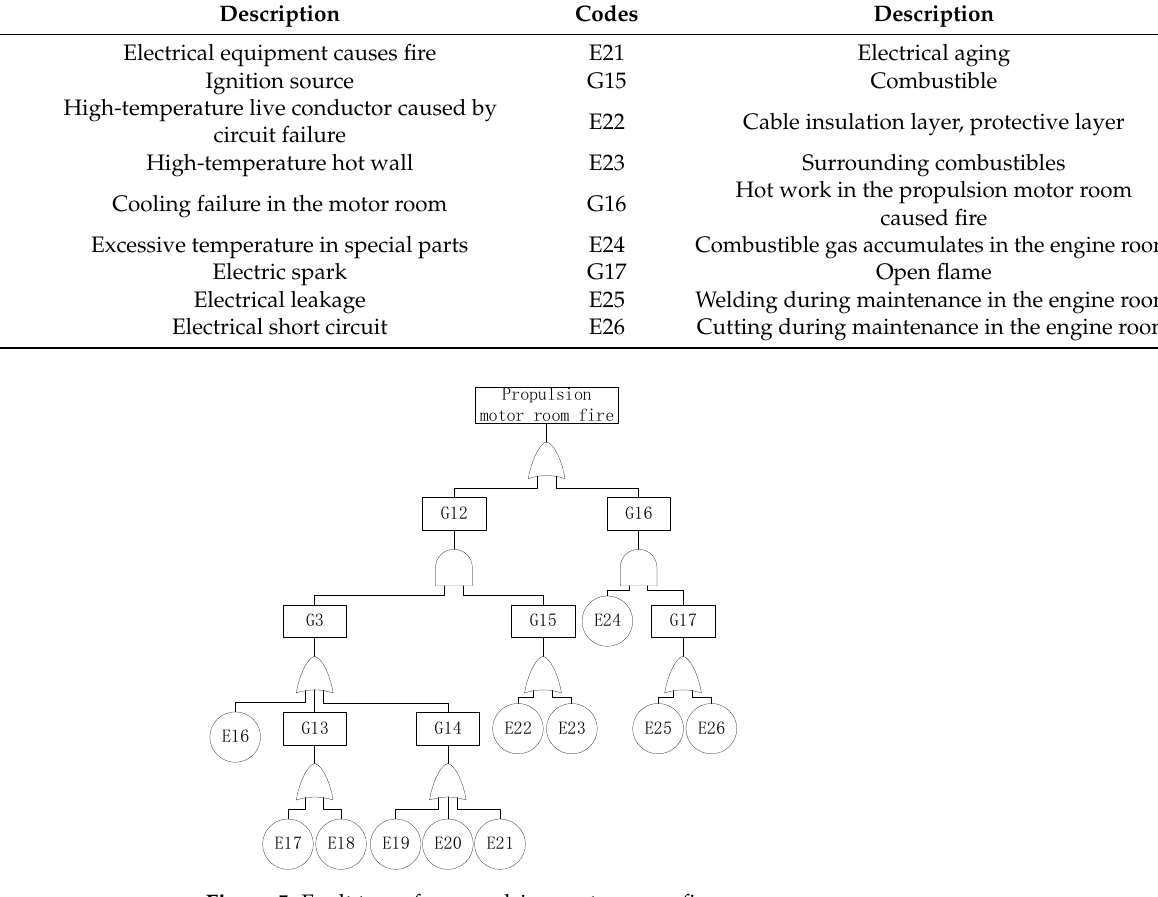
Figure 5. Fault tree of a propulsion motor room fire.